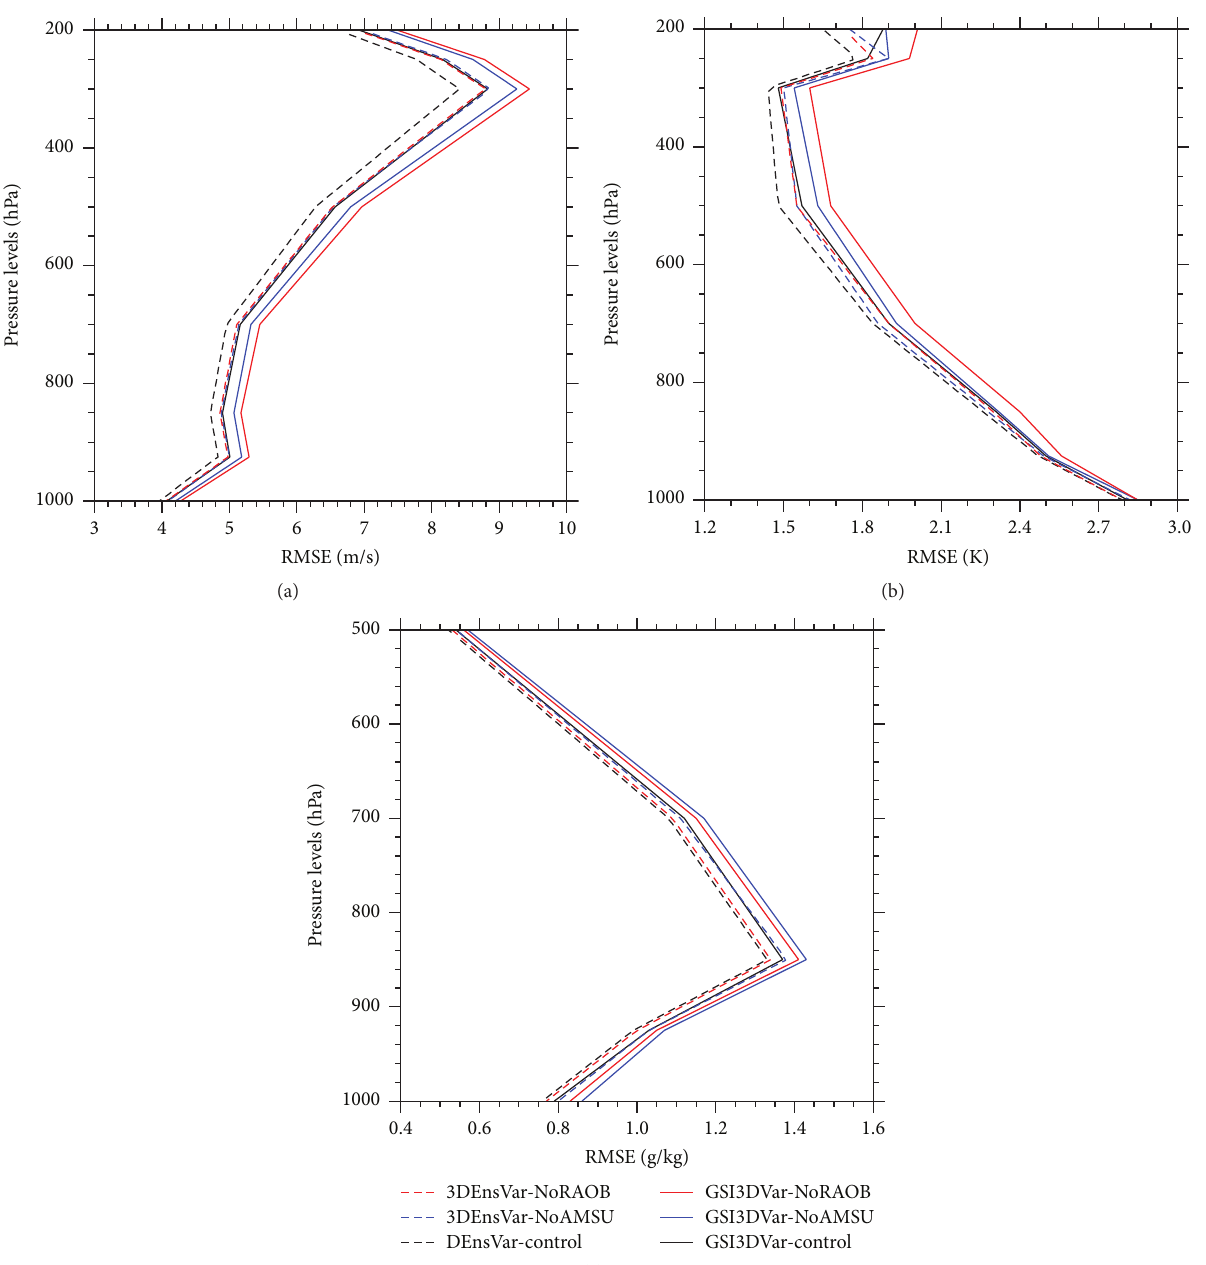
Figure 4: The root-mean-square fit of the forecast to the ECMWF analysis for (a) wind, (b) temperature, and (c) specific humidity at 72- h forecast lead time for the GSI3DVar and the 3DEnsVar experiments. Solid and dashed lines are for the GSI3DVar and the 3DEnsVar experiments. Black, blue, and red lines are for control, NoAMSU, and NoRAOB experiments,